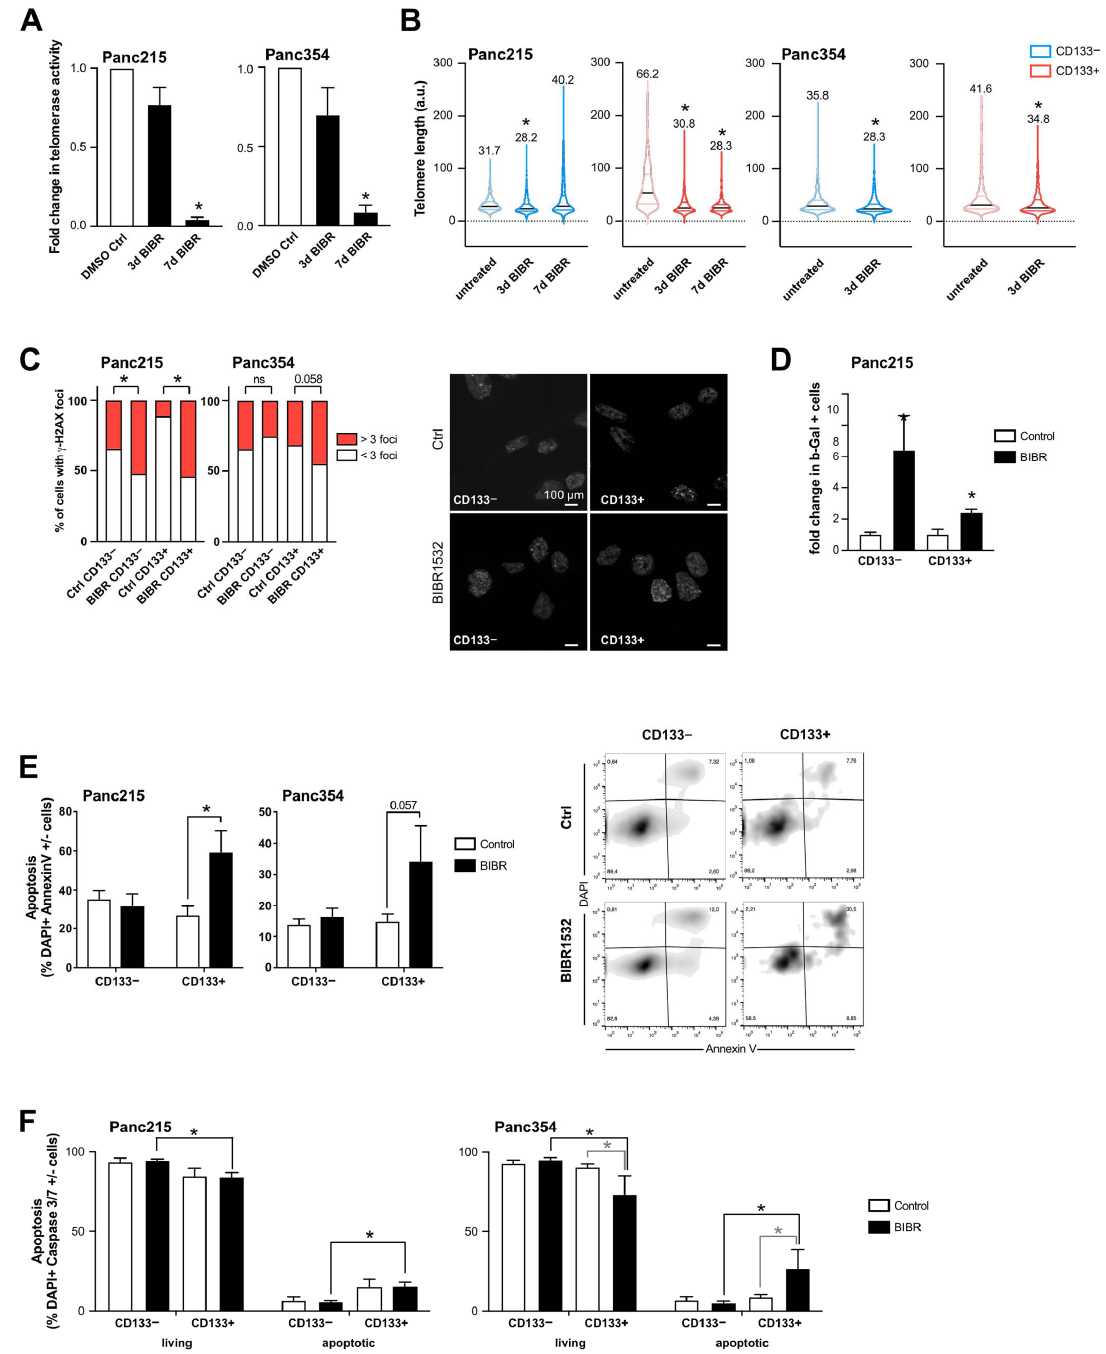
Figure 3. Targeting telomerase activity with a small molecule inhibitor (BIBR1532): ( A , B ) The effects of BIBR1532 treatment on telomerase activity ( A ), and telomere length ( B ) in CD133 − cells (blue) and in the CD133+ CSC population (red) were quantified. For illustrative purposes, the telomere length measurements of Figure 1H were re-used here (indicated by transparent color). The mean is depicted in numbers and as black line, >150 measurements per group. ( C ) Quantification of gH2AX foci (>50 cells per group) in CD133 − and CD133+ cells after 7 days vehicle or BIBR1532 treatment. Quantification and representative pictures of immunofluorescence staining of gH2AX foci are provided. ( D ) Senescent cells quantified by flow cytometry staining for SA-beta-Gal in CD133 − (non-CSCs) and CD133+ (CSCs) after BIBR1532 or solvent treatment (7 days). ( E , F ) Apoptosis quantified by flow cytometry using double staining for CD133 and AnnexinV or ( E ) Caspase3/7 ( F ). In ( A – F ), data are represented as mean ± SEM. n = 3 independent experiments. * p ≤ 0.05 (Mann–Whitney-U test), ns = not statistically